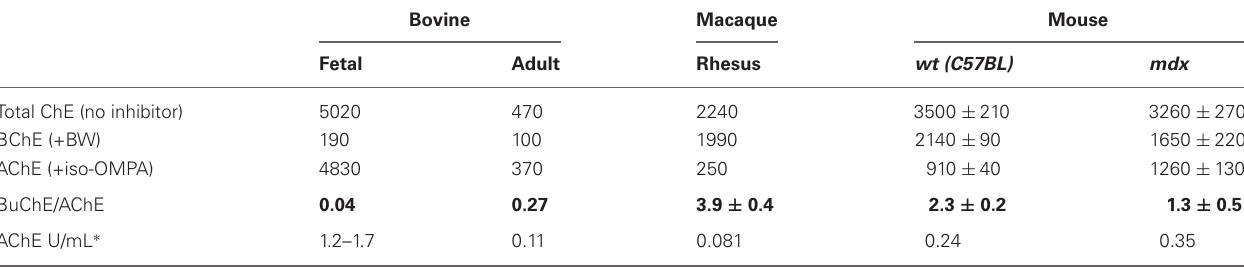
Table 4 | Species-specific variations in circulating ChE